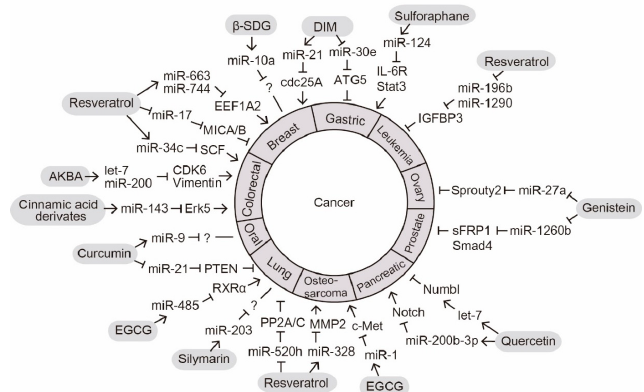
Figure 1. MicroRNA (miRNA)-mediated anticancer functions of phytochemicals. Phytochemicals regulate the expression levels of miRNAs implicated in the development of various cancers. Arrow indicates activation at the levels of expression; lines with a perpendicular line at the end indicates inhibition of expression; question mark indicates an unknown target molecule. In lung cancer cells, miR-520h is downregulated following resveratrol treatment, and consequently its target genes, PP2A/C, are derepressed [25]. PP2A/C inhibits AKT/NF- κ B-mediated FOXC2 expression. Since the FOXC2 is a key regulator that activates epithelial-mesenchymal transition (EMT) and metastasis, suppression of FOXC2 by resveratrol-mediated regulation of the miR-520h-PP2A/C axis induces mesenchymal-epithelial transition (MET) and exerts anticancer effects in lung cancer cells.